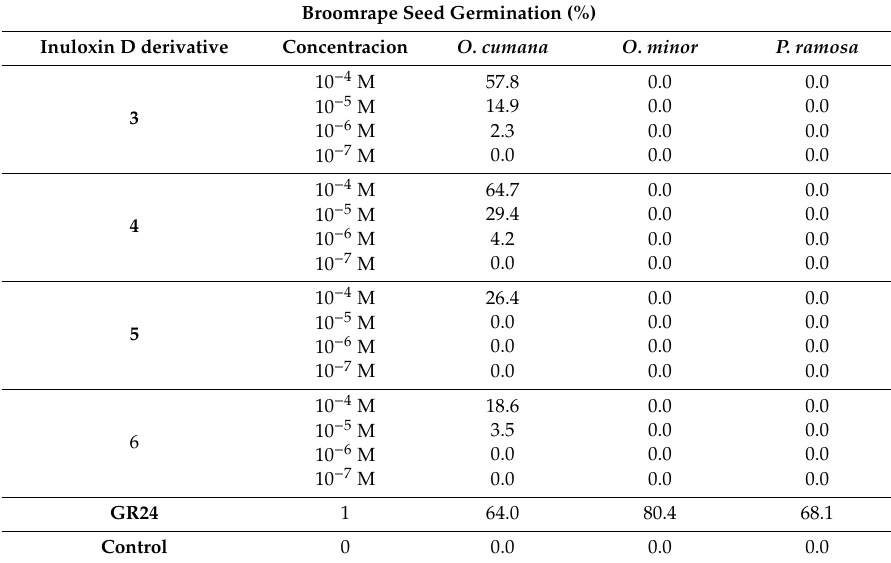
Table 3. The induction of seed germination of three broomrape species O. cumana , O. minor , and P. ramosa by inuloxin D derivatives ( 3 – 6